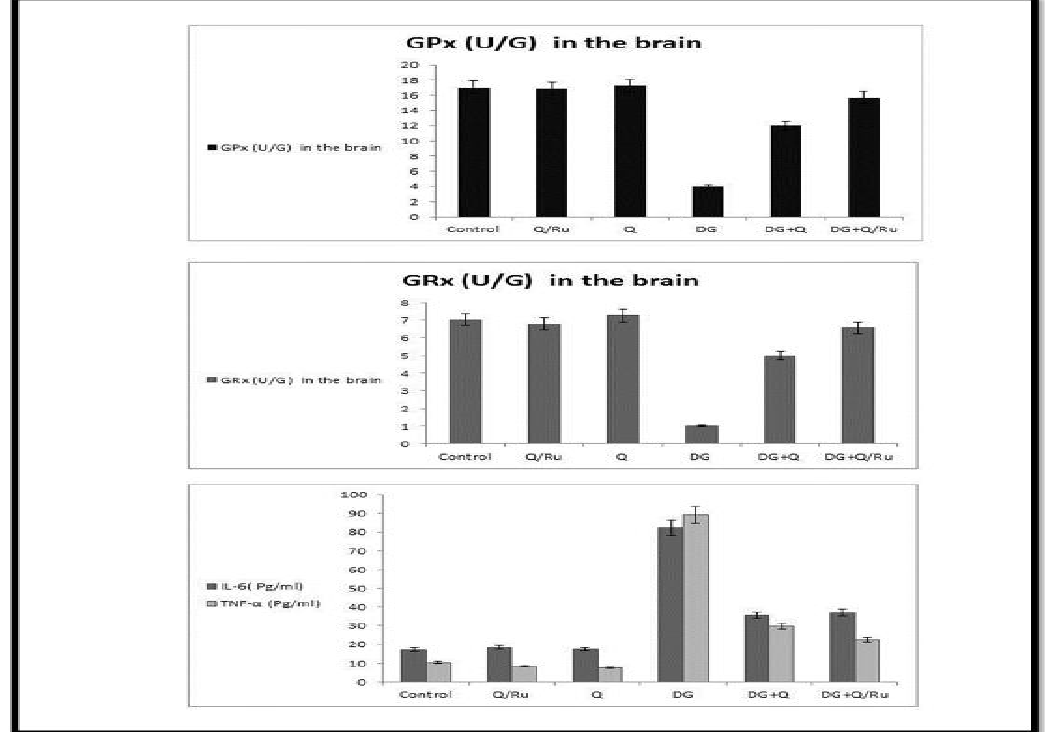
Figure 11. Effect of DG, Q and Ru III /Q alone or either combined on GPx, GRx, IL-6 and TNF-α levels.